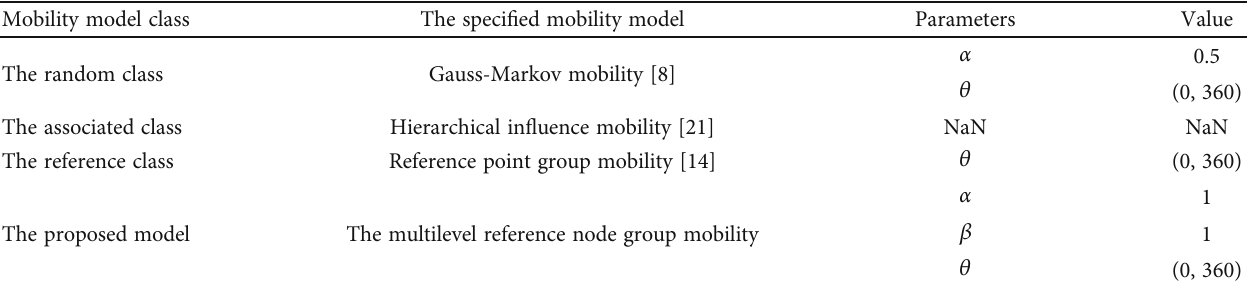
Table 5: The mobility model class parameters.